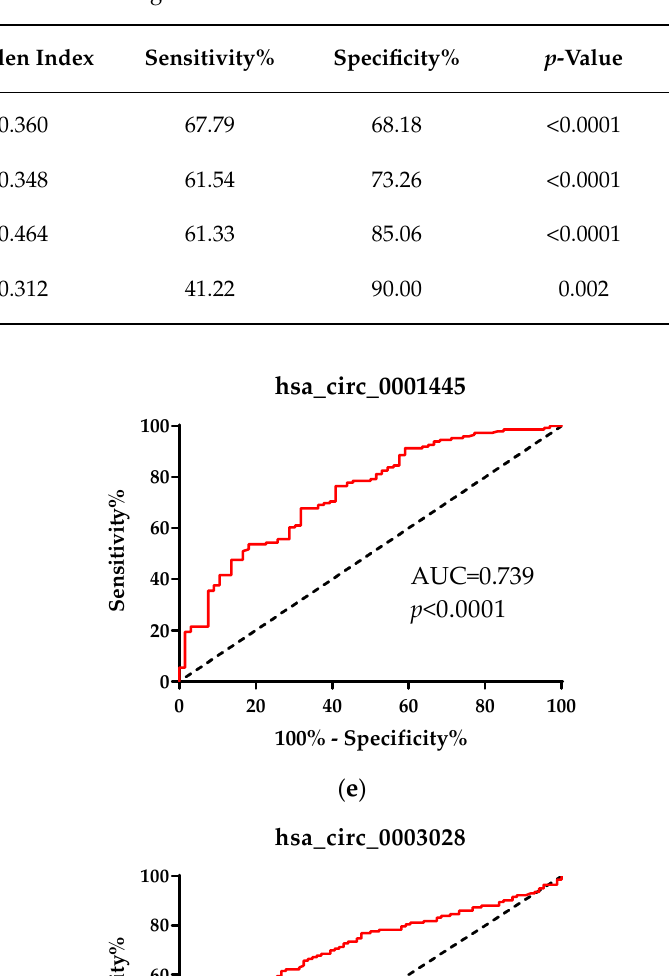
Table 1. Characteristics of circRNAs as a diagnostic biomarker.